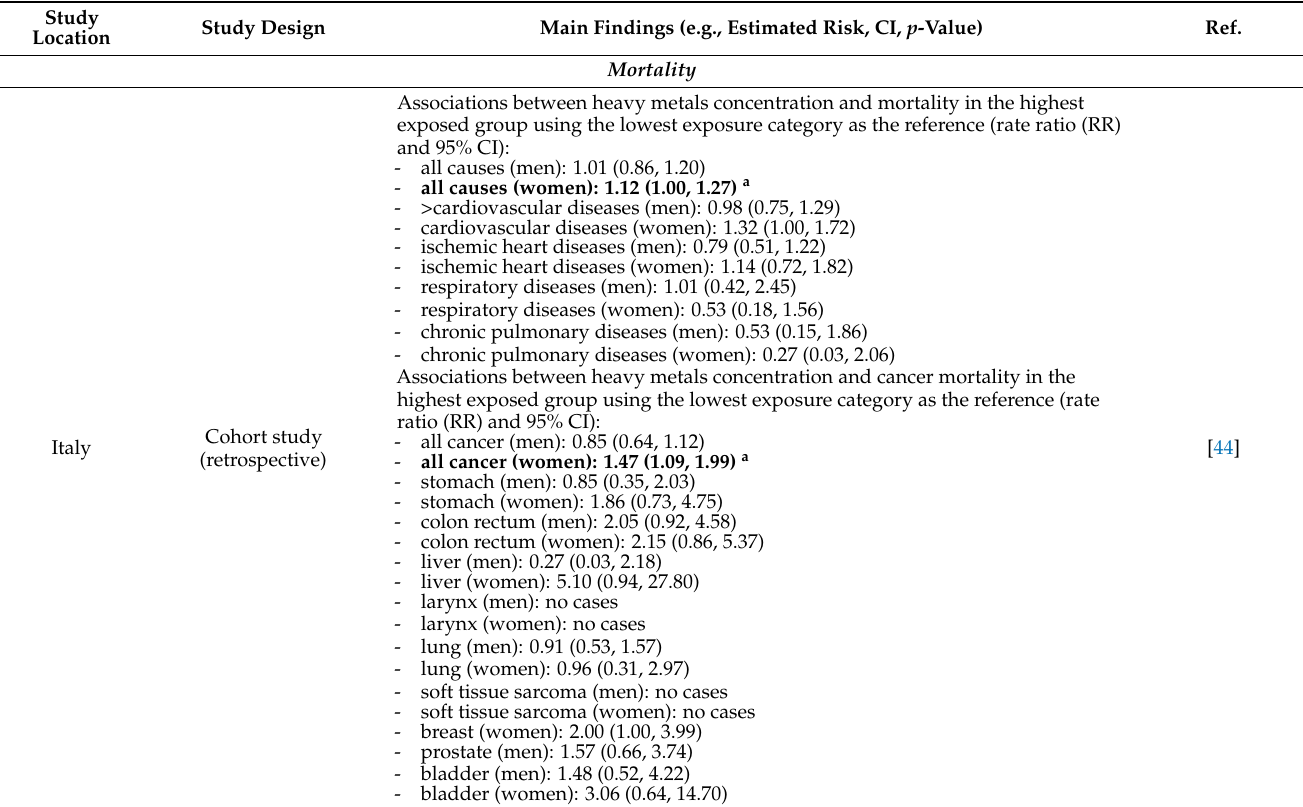
Table 4. Health outcomes associated with